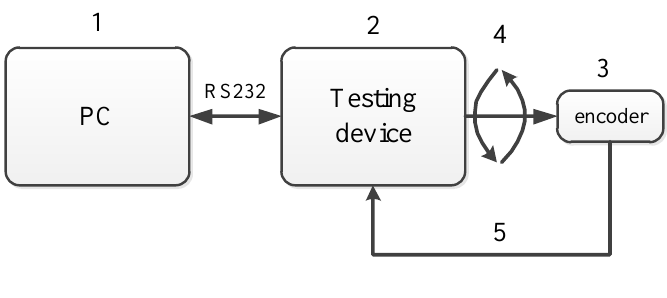
Figure 3. The structure of the overall system.